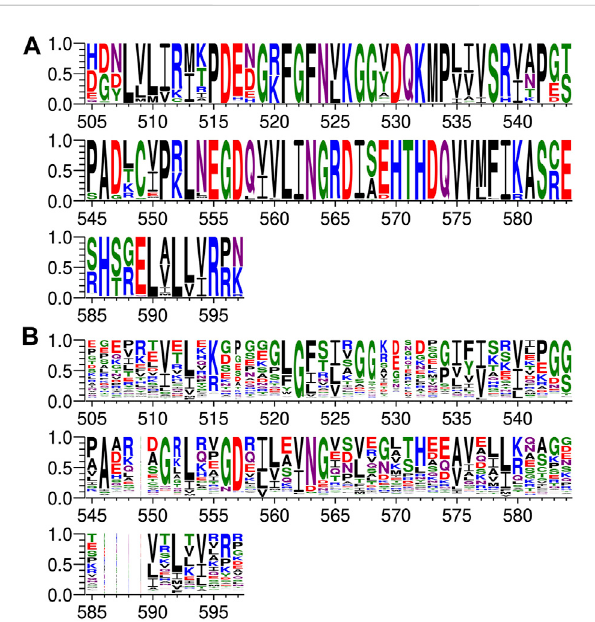
FIGURE 3 Comparison of PDZ domain sequence conservations from PTPN3 and PTPN4 orthologs and of the human PDZome. The result is displayed using a logo representation (Crooks et al., 2004), where the height of each residue one-letter code translates to its conservation at the corresponding position of the PTPN3-PDZ numbering in the sequence alignment. Sequence logo showing the sequence conservation of (A) PTPN3 and PTPN4 orthologs and of (B) the human PDZome.